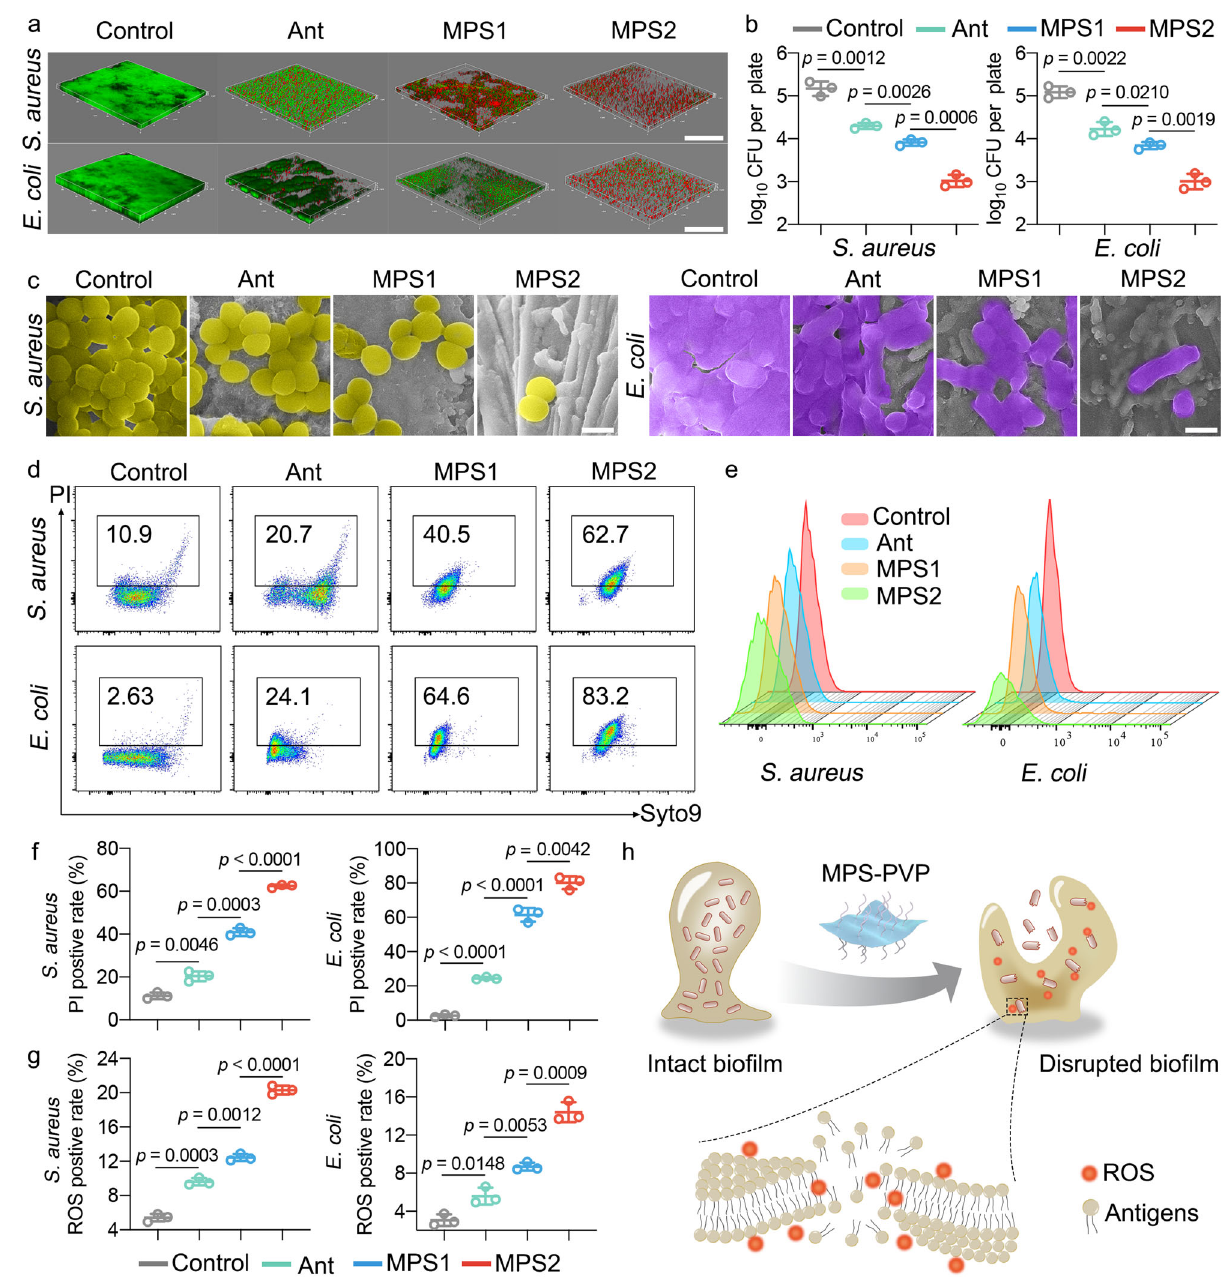
Fig. 3 | MPS-PVP leverages bio fi lm as an endogenous antigen deposit. a 3D confocalmicrographsofbio fi lm(livebacteria,green;deadbacteria,red).Scalebar, 100 μ m. b quantitative analysis of bio fi lm biomass (log 10 CFU per titanium plate). c SEM images of bio fi lm. To better visualize the bio fi lm, S. aureus were pseudo- colored yellow, while E. coli were pseudo-colored purple. Scale bar, 1 μ